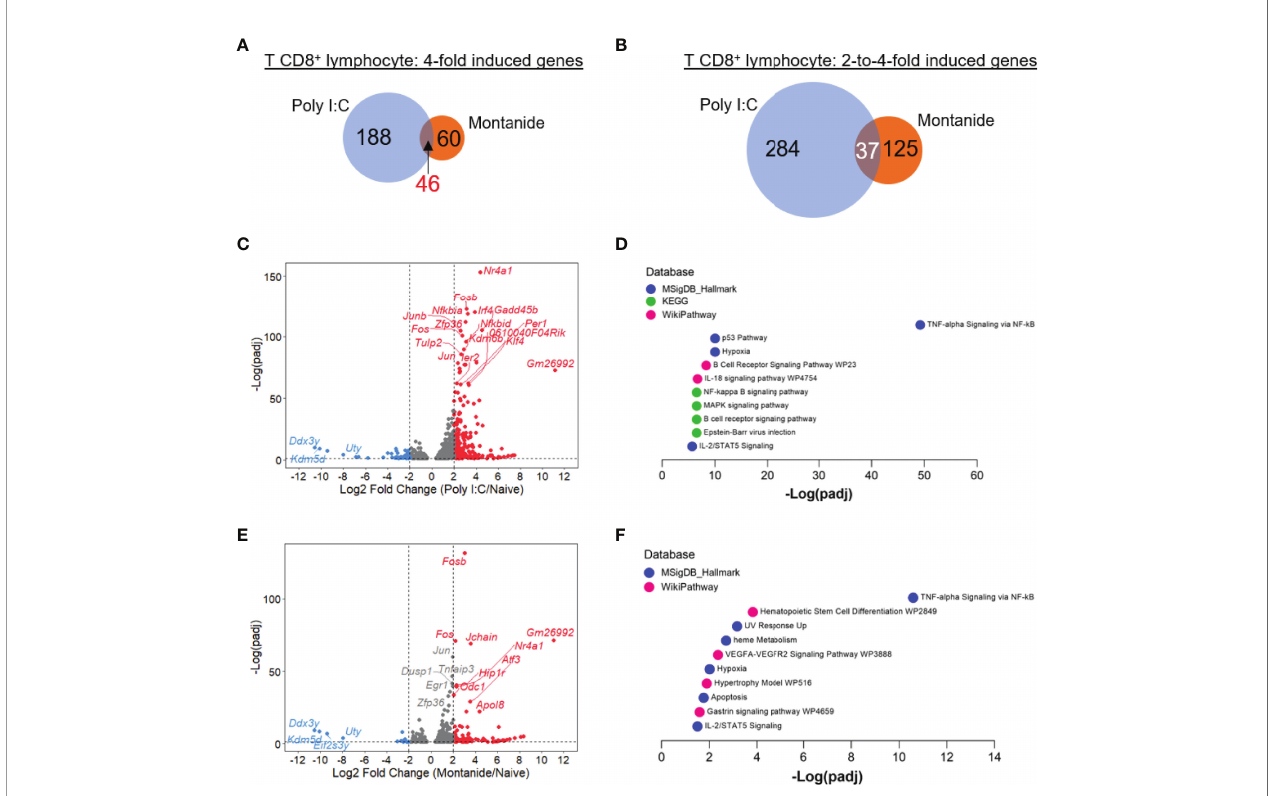
FIGURE 5 | Poly (I:C) induced stronger perturbation in T CD8 + lymphocyte transcriptome in comparison to Montanide ISA 720. Differentially expressed genes (DEGs) were determined with the R-Bioconductor DESeq2 package, using the raw reads from the different samples as input. Genes that displayed a p-adjusted < 0.05 were considered for downstream analysis. (A, B) , Venn mulsionMontanide-adjuvanted or in both groups of mice. (C) , volcano plot highlighting the Poly (I:C)- induced DEGs. (D) , gene enrichment analysis of the 4-fold-induced genes by Poly (I:C), performed with the Enrichr webtool. (E) , volcano plot highlighting the Montanide-induced DEGs. (F) , gene enrichment analysis of the 4-fold-induced genes by Montanide ISA 720, performed with the Enrichr webtool.